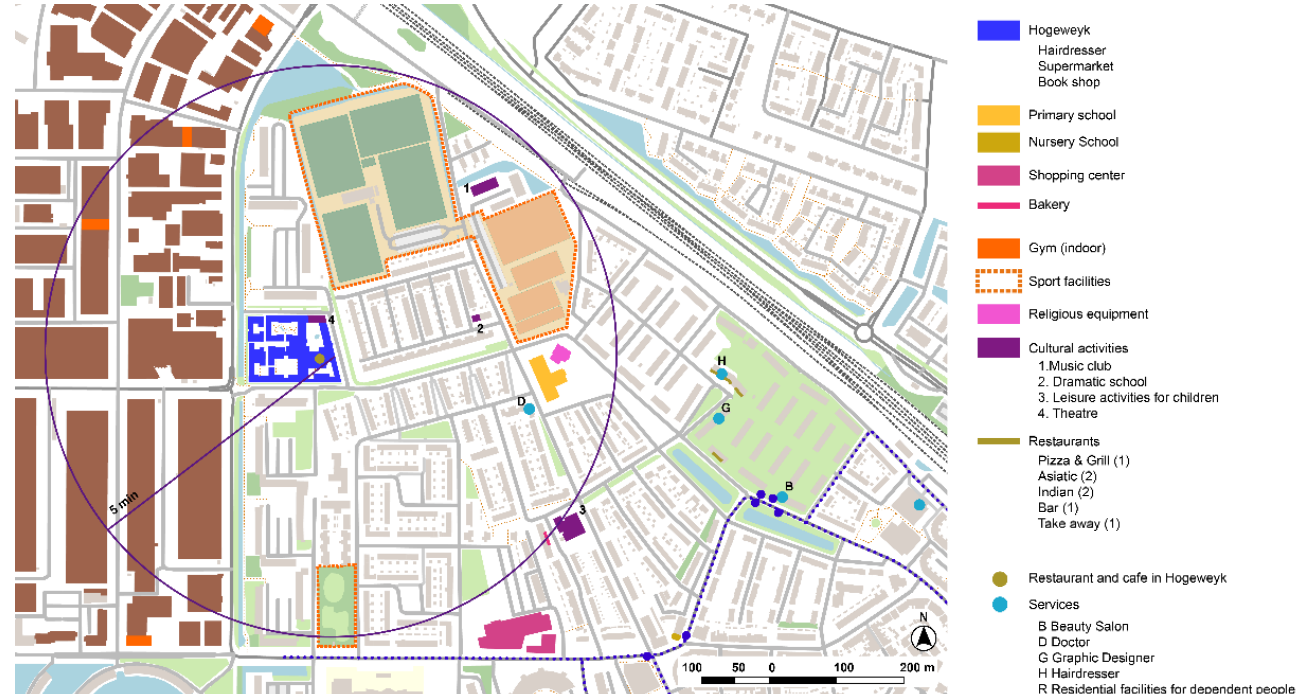
Figure 20. Analysis of the close surroundings of the De Hogeweyk project in Weesp. Source: Own elaboration.